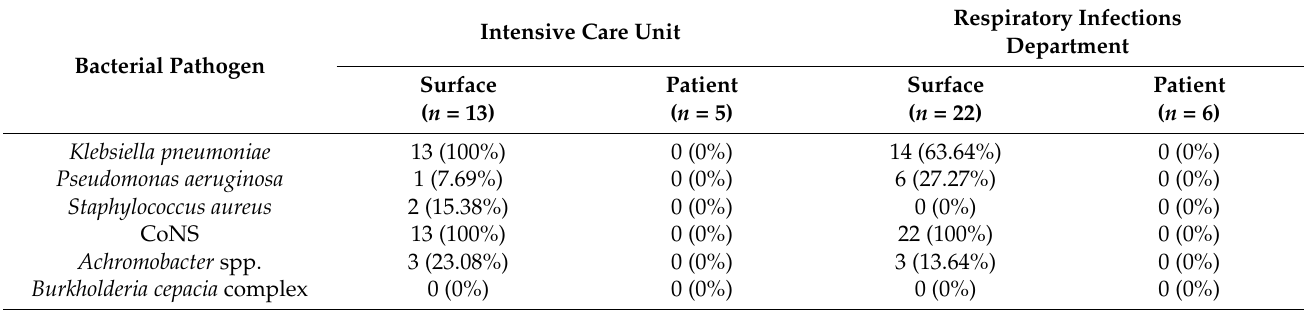
Table 1. Number of positive detections in surface samples and in nasopharyngeal swabs from patients by PCR.